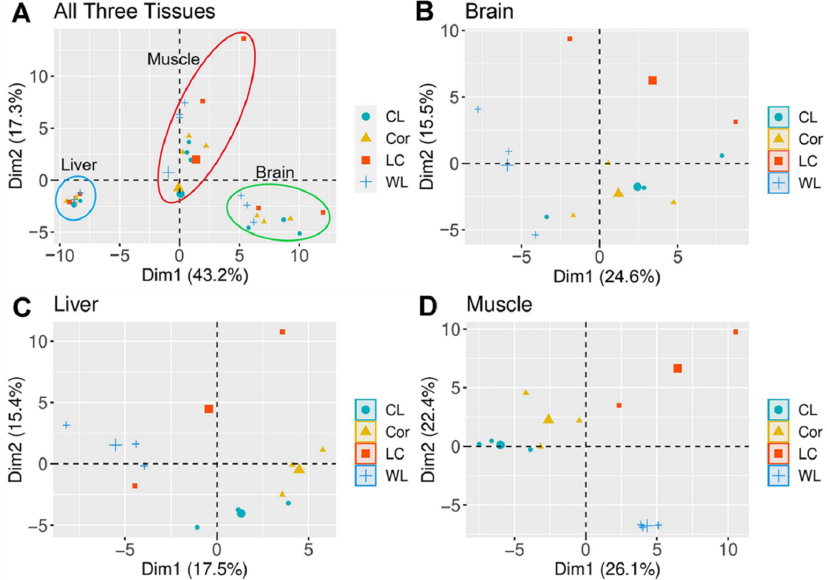
Figure 4. Principal Component Analysis using RNA-seq data. ( A ) PCA results of all three tissues, the sample is divided into 3 different clusters according to the 99% confidence interval. ( B ) PCA results of the brain. ( C ) PCA results of the liver. ( D ) PCA results of muscle. Each dot represents an individual, and dots with different shapes and colors indicate different varieties.